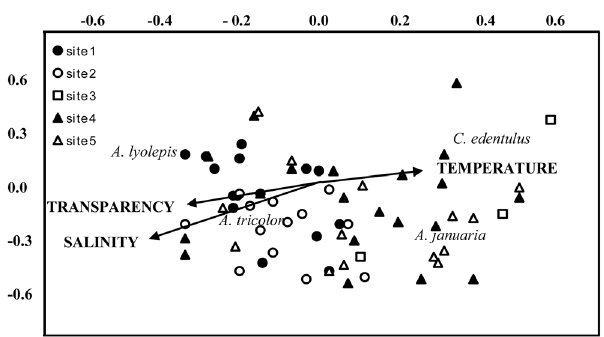
Fig. 3. Canonical correspondence analysis ordination diagram